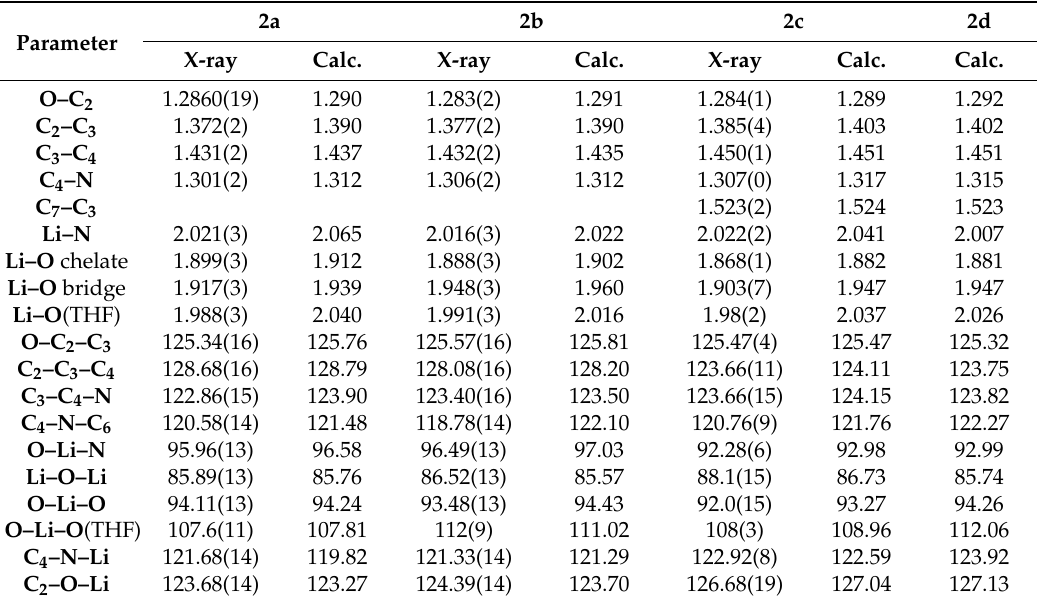
Table 2. Experimental 1 and calculated 2 bond lengths (Å) and angles ( ◦ ) for 2a – d